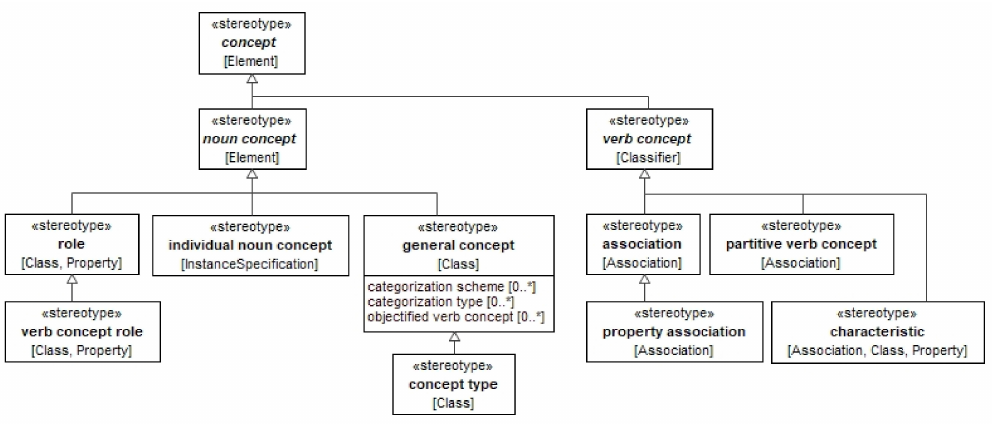
Figure 1. Fragment of UML profile for SBVR Business Vocabulary